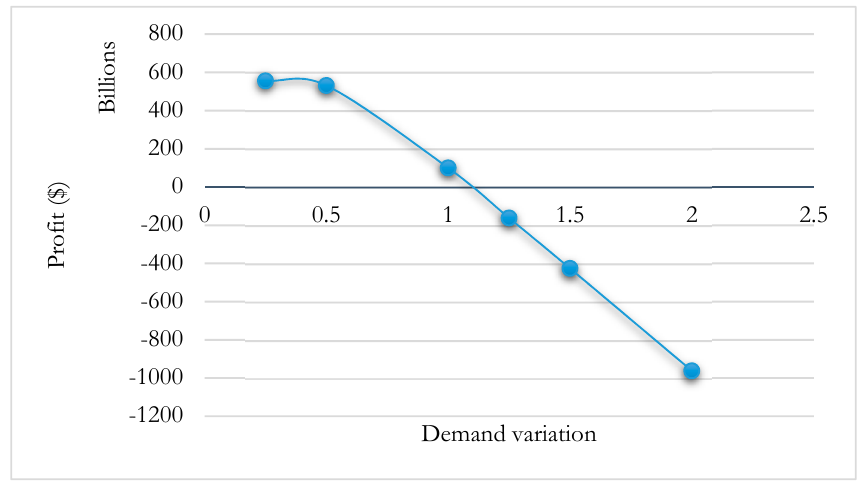
Figure 9. Profitability changes with the variation in demand.